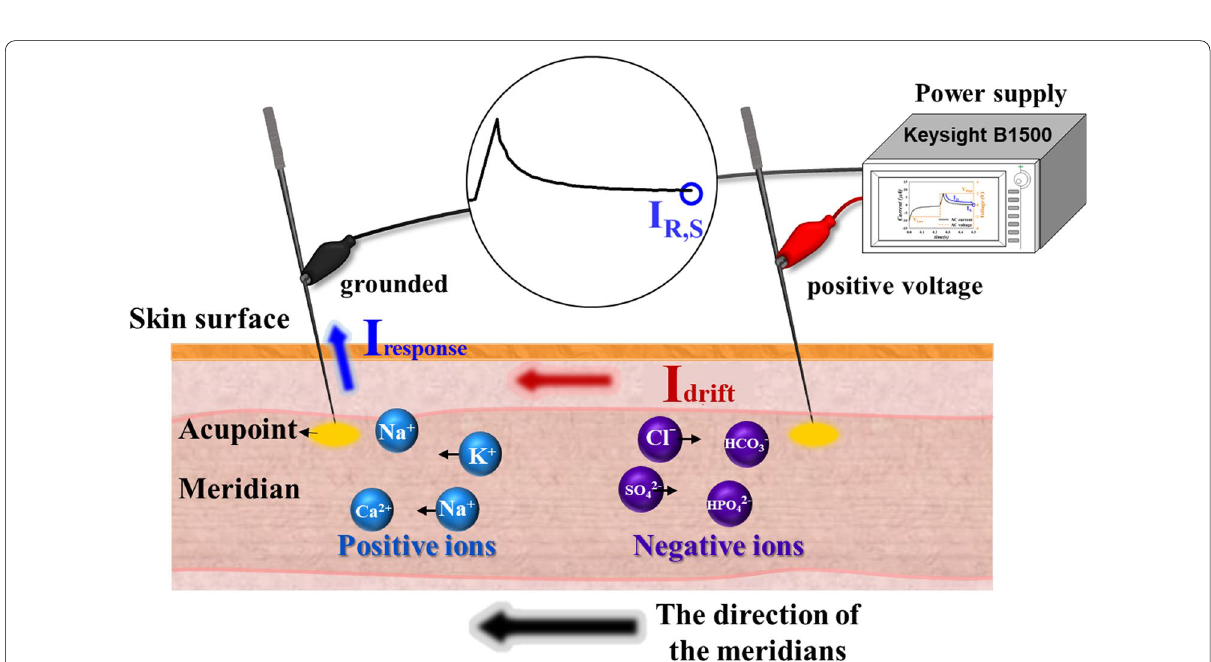
Fig. 7 The direction of the positive and negative ions after applying positive voltage for a long time. The ions accumulate at the